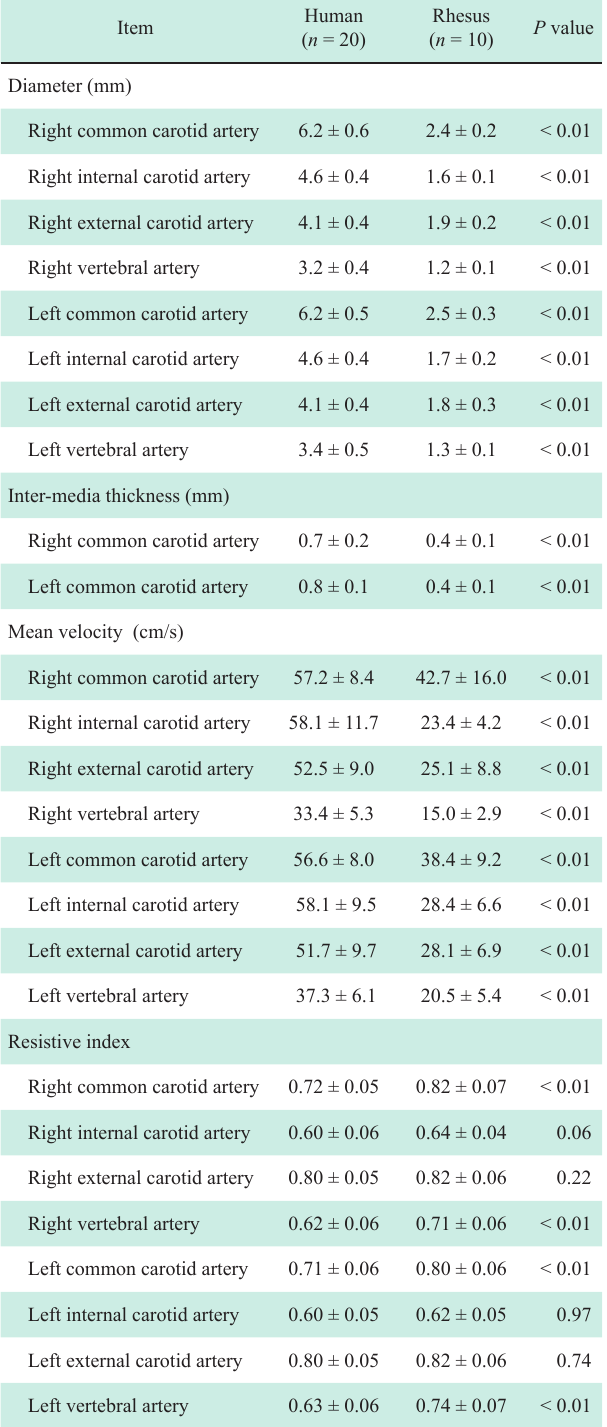
Table 2 Extracranial carotid artery parameters between human and rhesus monkeys